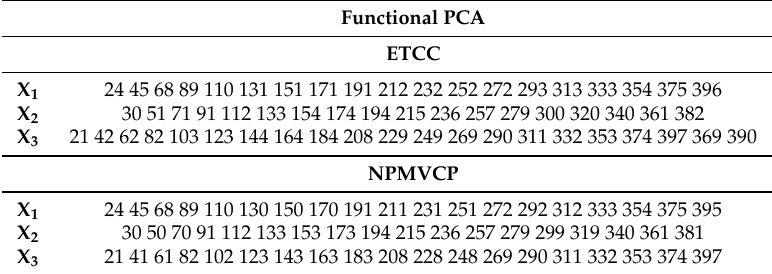
Table 7. Change point detection by ETCC and NPMVCP of functional PCA (FPCA) with simulated multivariate data.